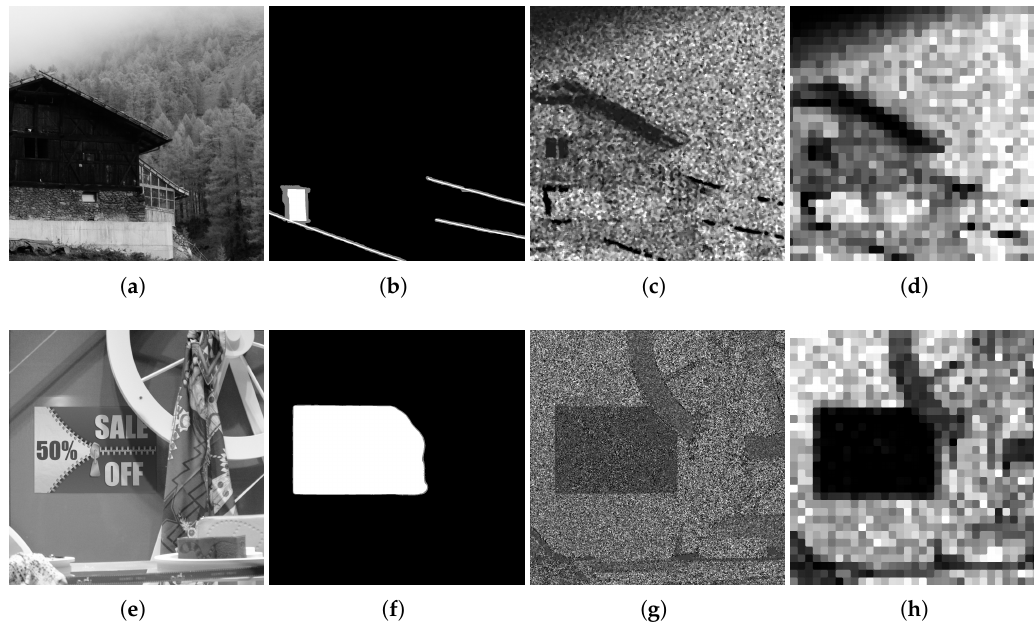
Figure 13. Misbehaviour of detection depending on the block size. The first column shows the analyzed images. In the second column, images ( b , f ) highlight the modifications in white. Images ( c , g ) represent the result of the analysis on the images with a block of size 2 × 2. Finally, images ( d , h ) exhibit the performance on blocks of size 32 × 32.